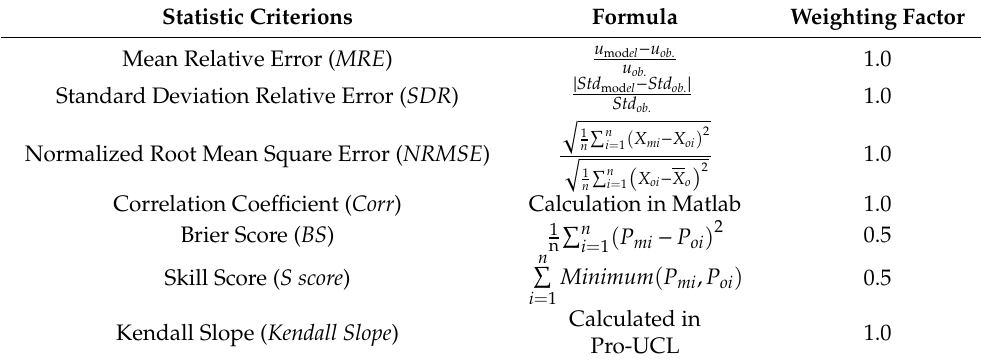
Table A1. Statistical criteria for evaluating GCMs. The weighting factor assigned to each criterion also is